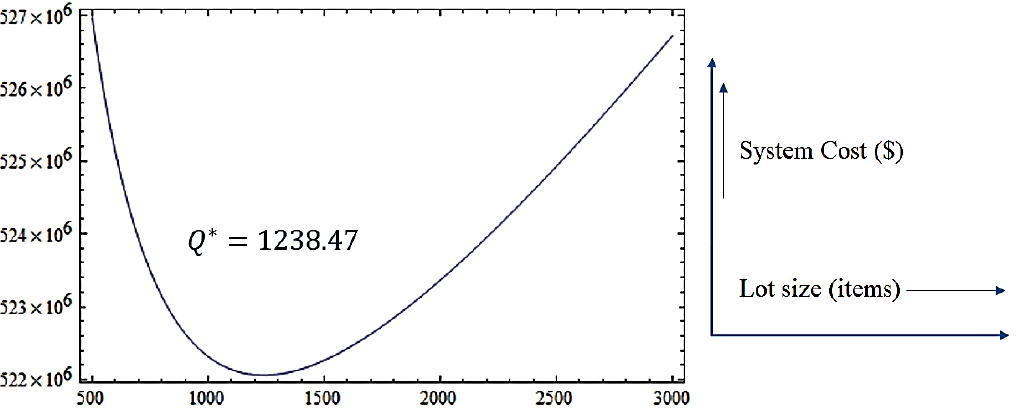
Figure 8. Objective function convexity diagram for Example 3 (Five-stage production system).